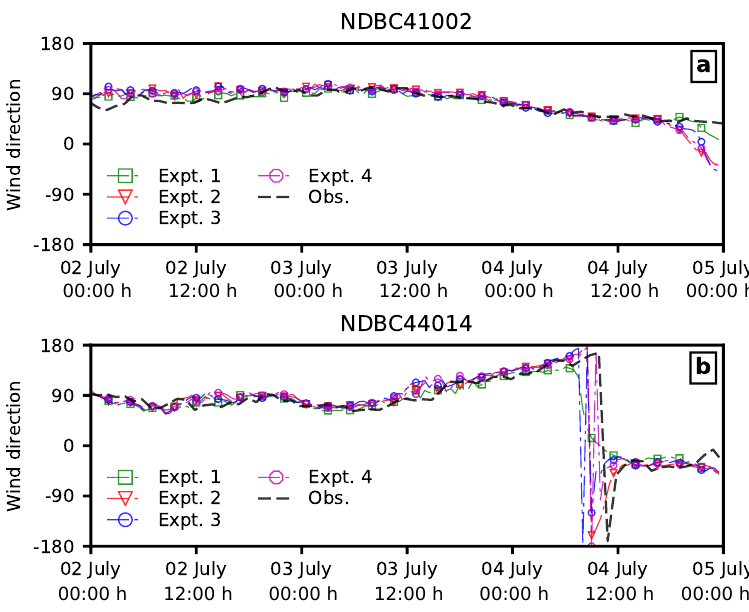
Figure 8. As in Fig. 7, but for wind